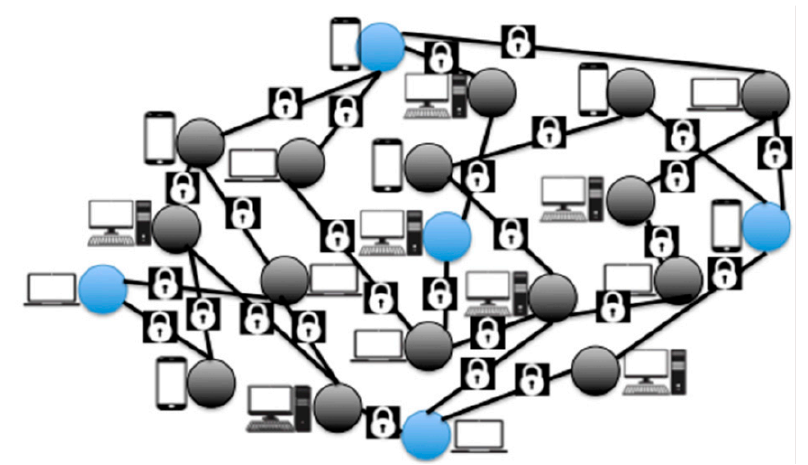
Figure 4. Consortium Blockchain.